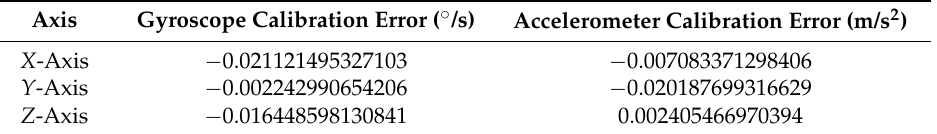
Table 3. Six position calibration results.